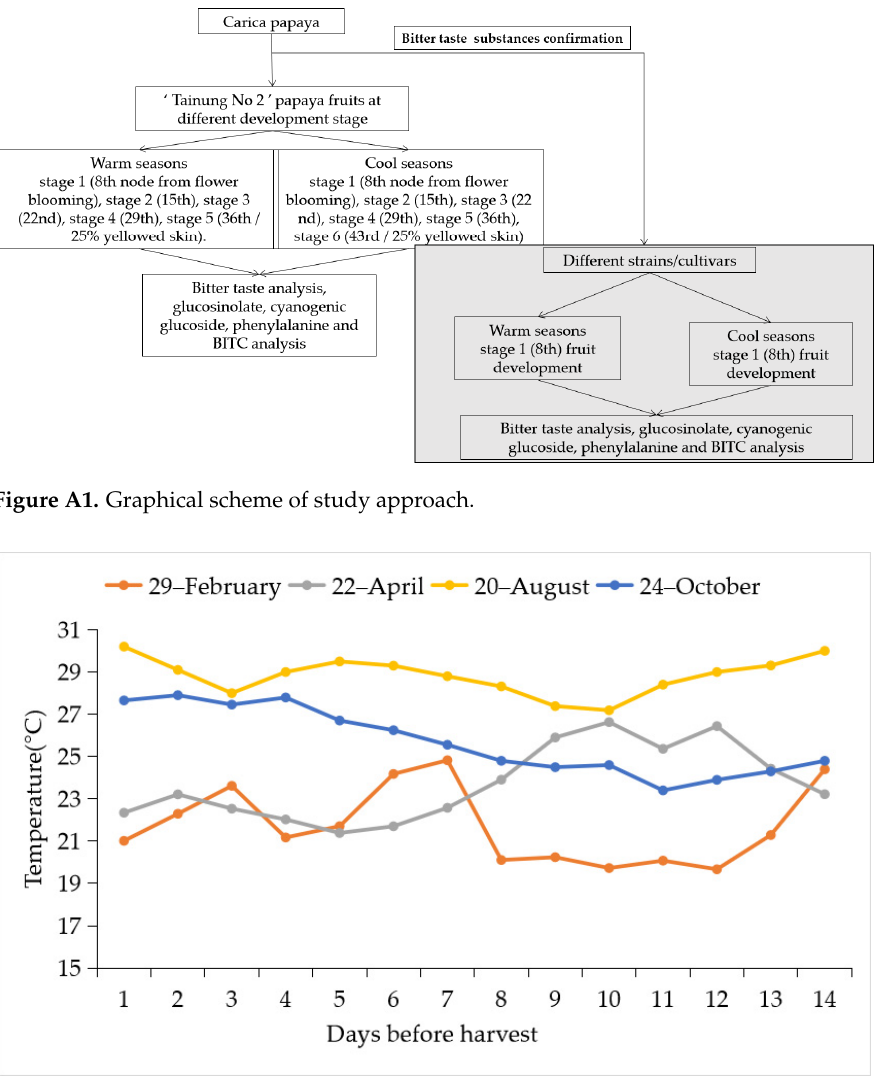
Figure A2. Fourteen days of average temperature of papaya fruits before